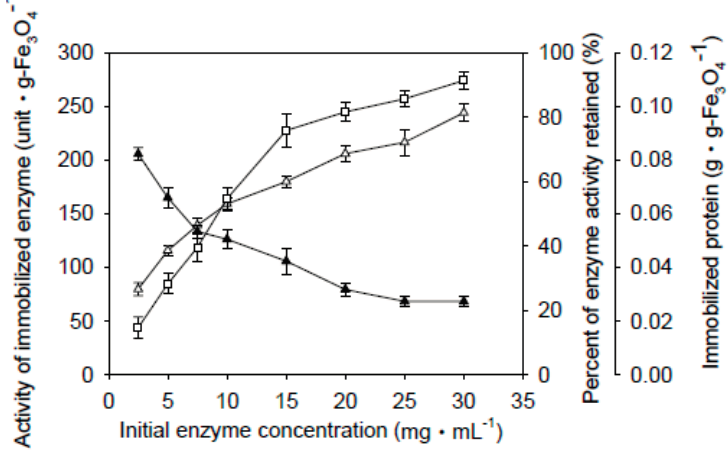
Figure 1. Adsorption equilibria of Fe 3 O 4 -CS-THP-immobilized β -galactosidase. 0.5 g of Fe 3 O 4 -CS-THP was added to 4 mL of β -galactosidase solution at various concentrations, and enzyme immobilization was allowed to proceed with mild shaking at 25 °C for 2